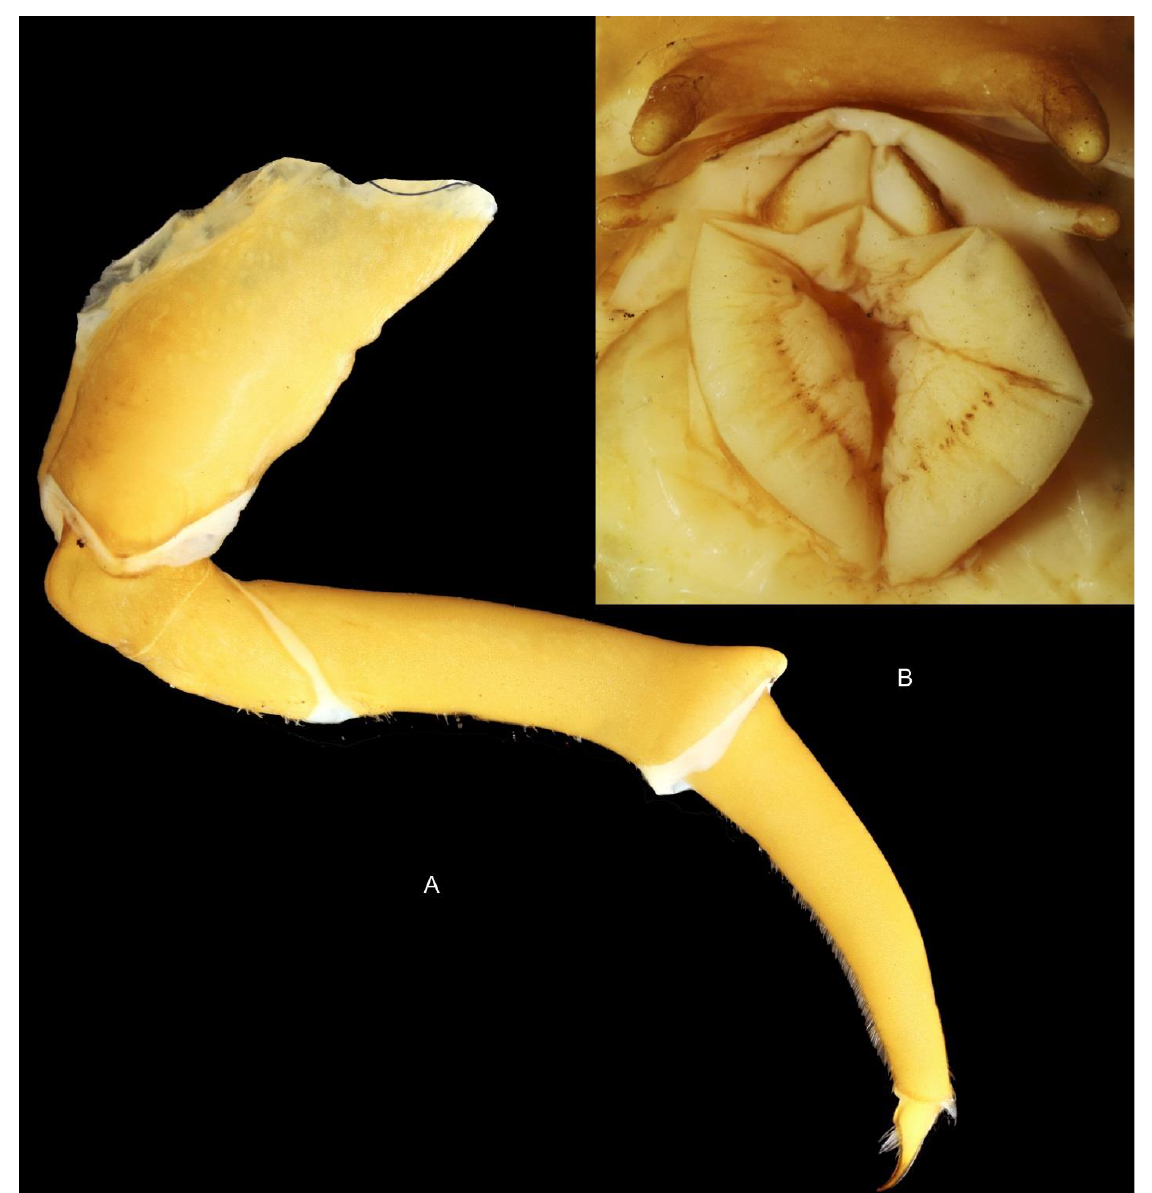
Figure 7. Platerodrilus svetae , female. ( A ) — mesoleg; ( B ) — IX and X segments, ventrally.